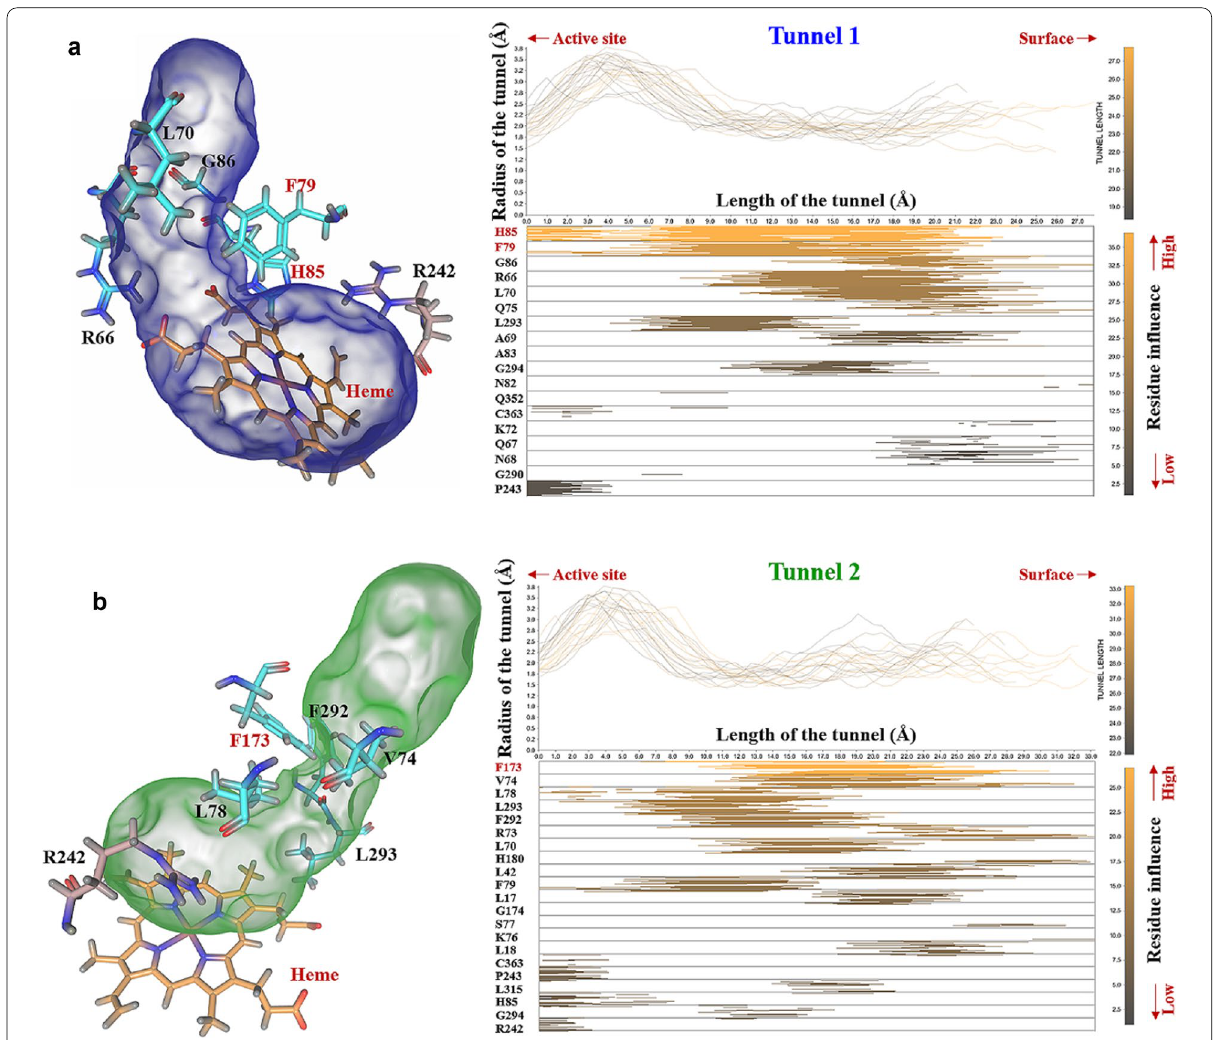
Fig. 2 Evolution of residues lining the access tunnels of P450 Bsβ HI. The access tunnel analysis was carried out with Caver Analyst 2.0 BETA. The left part is bottleneck residues lining of tunnel 1 and 2. The upper right part shows graph representation plots the tunnel width along its centerline. Each line represents the tunnel in one timestep. The lower right part describes the list of all residues contributing to the tunnel. The horizontal position of the color in the line shows which part of the tunnel this residue influences. All tunnel structure information was from the 5-ns snapshot of MD